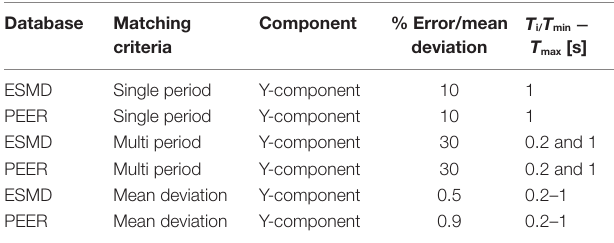
TaBle 4 | spectral matching